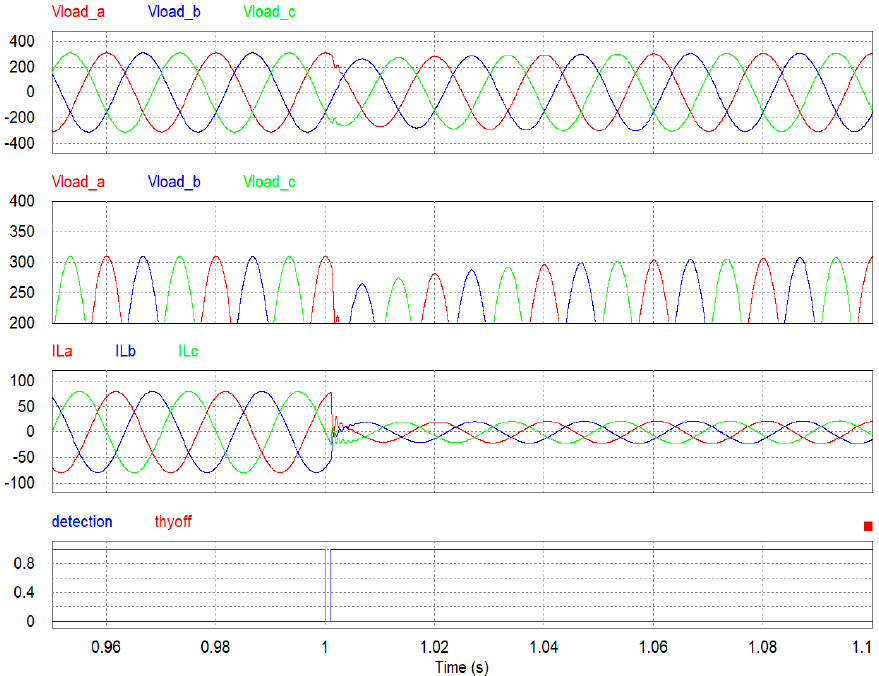
Figure 8. Simulation result of mode switching using a conventional proportional-integral (PI) controller.